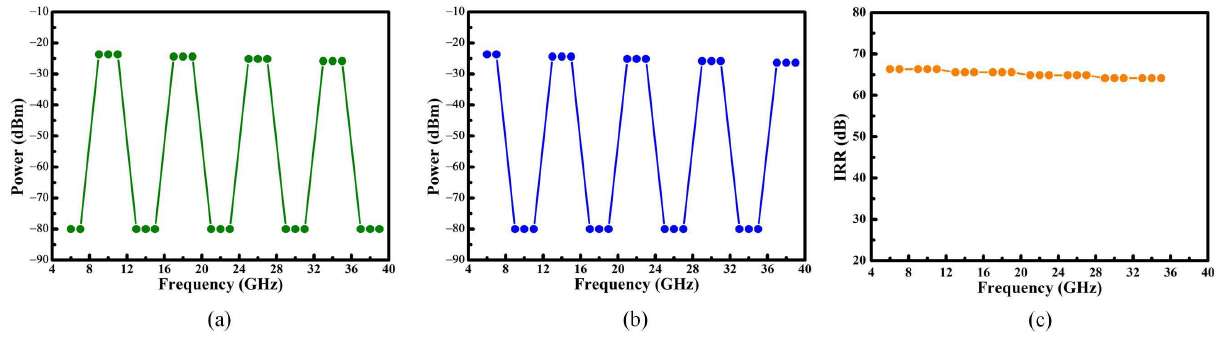
Figure 2. Frequency response of the image-rejected down-converter by setting the quadrature coupling method of the two photocurrents as ( a ) I x ( t ) e j π 2 + I y ( t ) and ( b ) I x ( t ) + I y ( t ) e j π 2 . ( c ) Image rejection ratios (IRRs) of the mixer with respect to the input signals at different frequencies.